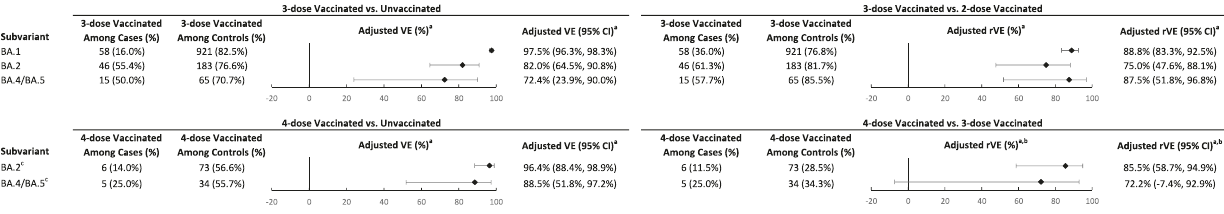
Fig. 4 | Adjusted vaccine effectiveness (VE) and relative vaccine effectiveness (rVE) of mRNA-1273 against hospitalization for omicron subvariants by time since3rd or4thdosevaccination. Adjusted VEof 3and fourdosesof mRNA-1273 andadjustedrVEof3versustwodosesand4versusthreedosesofmRNA-1273and their 95% con fi dence intervals against hospitalization for SARS-CoV-2 omicron subvariants. Sample size for each analysis equals the number of three-dose vacci- nated divided by the percentage of three-dose vaccinated for the three-dose models, and is equal to the number of four-dose vaccinated divided by the per- centage of four-dose vaccinated for the four-dose models. a Adjusted for age, sex, race/ethnicity, month of specimen collection, history of SARS-CoV-2 infection,